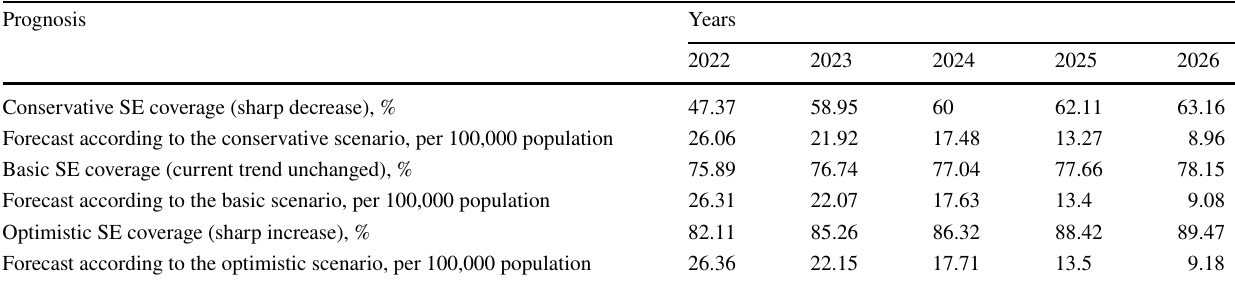
Fig. 1 Forecast of the overall tuberculosis incidence in the Russian Federation with the basic